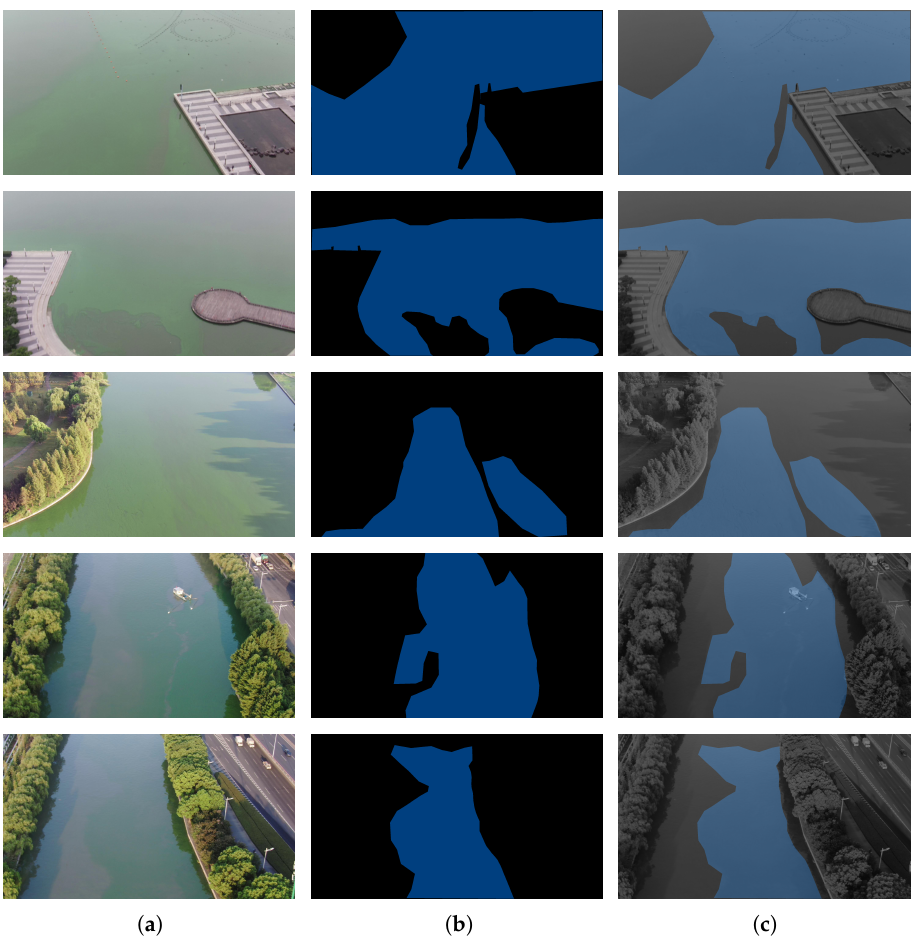
Figure 17. Raw images and masks in dataset. The first column titled ( a ) are the original images taken by UAVs. The second column titled ( b ) are the labels, with the blue areas representing blue-green algae. The third column titled ( c ) are the fused images, in order to clearly present the results; ( a ), raw images; ( b ), masks; ( c ),